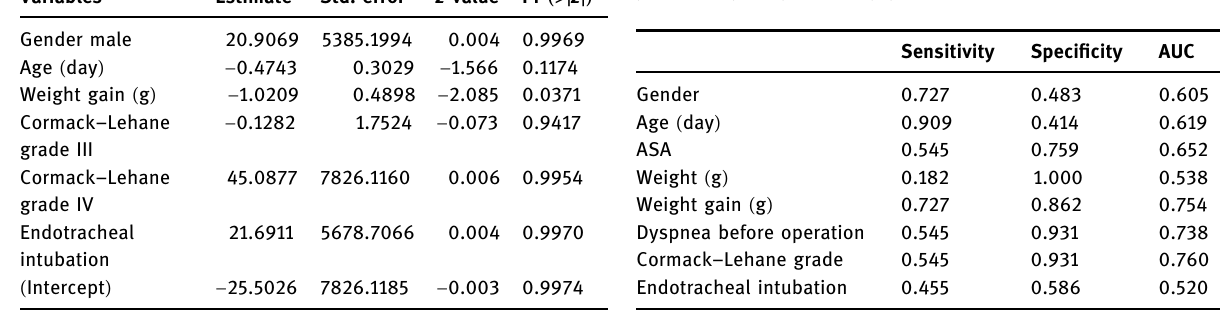
Table 3: Logistic regression model to predict postoperative